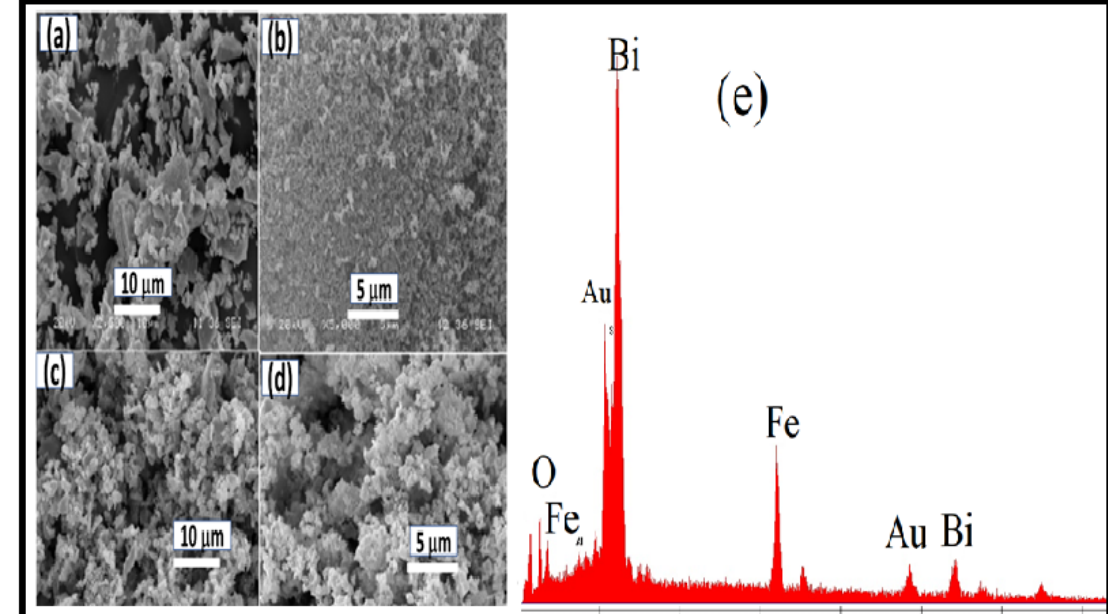
Figure 3. SEM images of ( a ) BFO ( b ) Carbon ( c ) S 80 BFO 10 C 10 ( d ) S 60 BFO 30 C 10 ( e ) EDS spectrum S 60 BFO 30 C